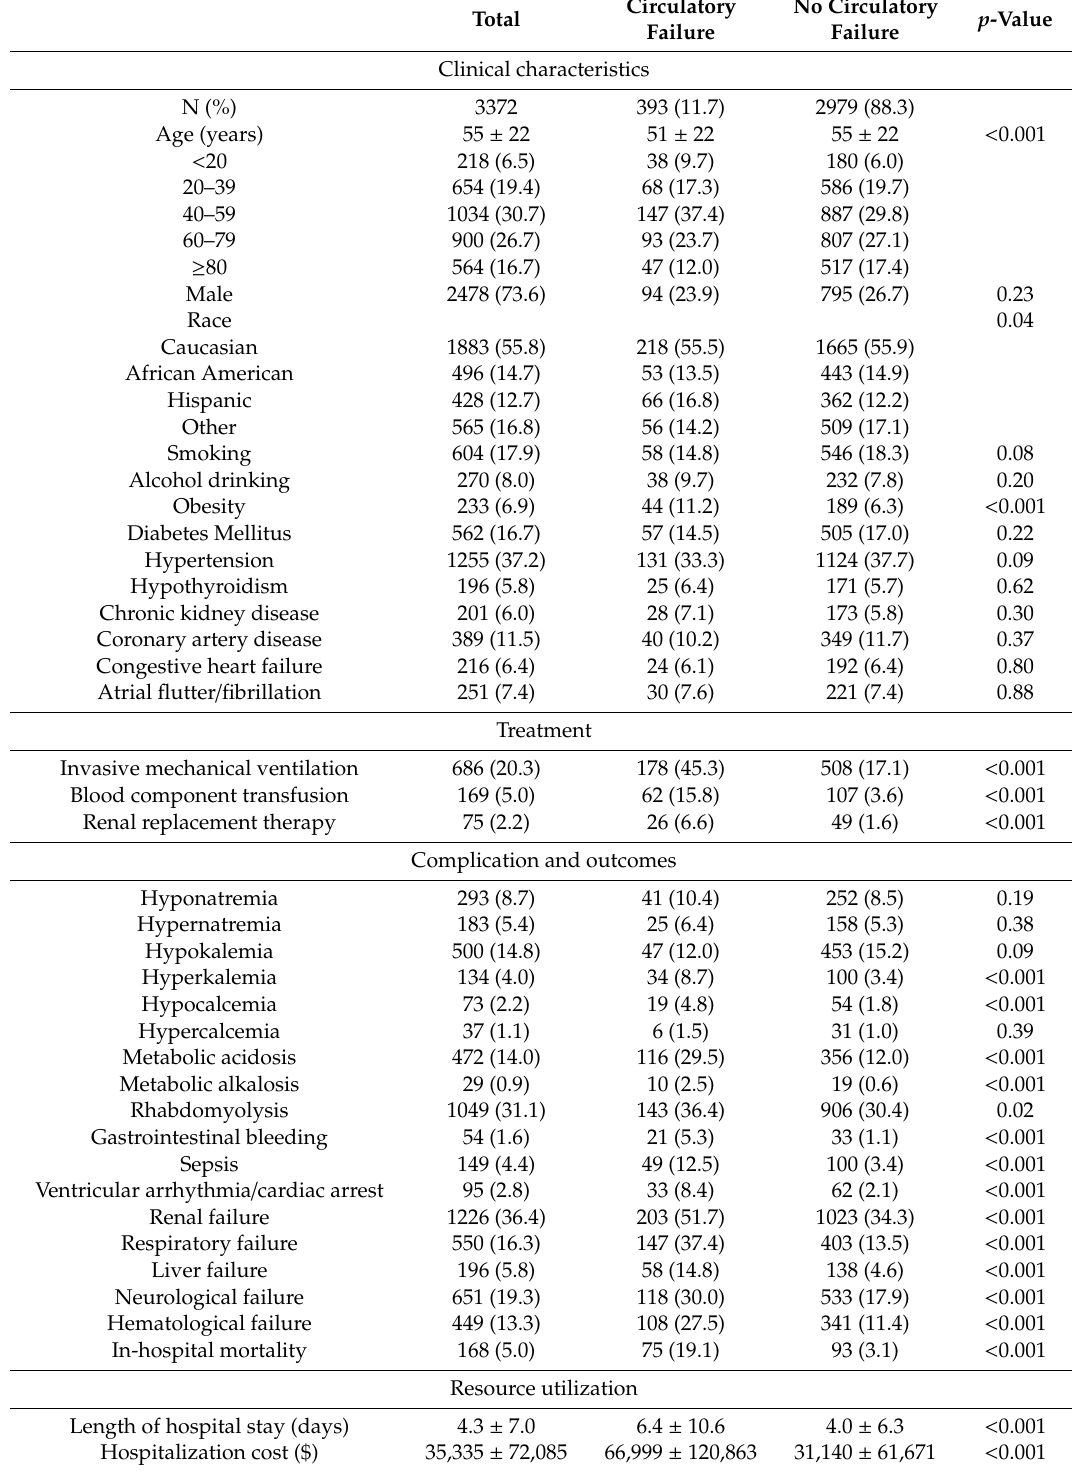
Table 1. Clinical characteristics, in-hospital treatments, complications, outcomes, and resource utilization in heatstroke